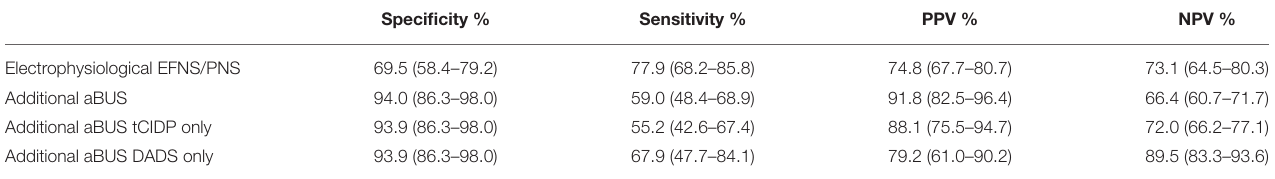
TABLE 5 | Sensitivity, specificity, PPV, and NPV for differentiation of chronic inflammatory neuropathies from NIAP using electrophysiological EFNS/PNS criteria (2) only vs. using aBUS additionally in patients with possible and probable CIDP diagnosis according to electrophysiological EFNS/PNS criteria (2).